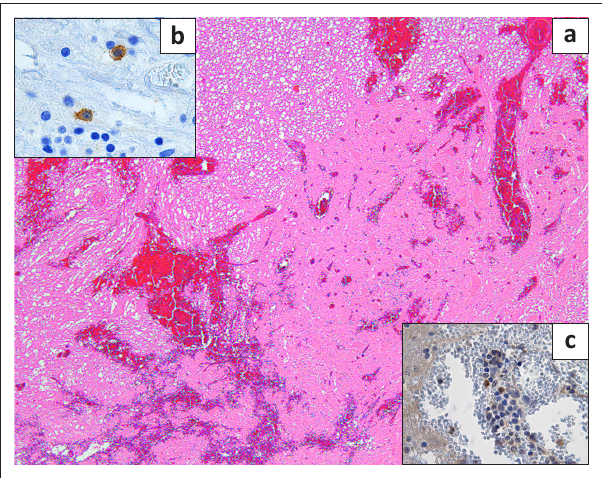
Source : Image was taken by June Williams HE x 40. FIGURE 3: (a) Lumbar spinal cord of lineage 2 West Nile virus Case 2 with severe multifocal to coalescing haemorrhage involving white and grey matter. (b) Case 2 cauda equina spinal cord ventral horn grey matter with two immunohistochemistry cluster of differentiation 20+ (brown) labelled plasma cells in parenchyma. Cluster of differentiation 20 immunoperoxidase using LSAB+ DAB as chromogen and haematoxylin counterstain x 1000. (c) Case 2 cauda equina grey matter perivascular immunohistochemistry Multiple myeloma oncogene1+ plasma cells (dark brown-black staining round nuclei). Multiple myeloma oncogene1 immunoperoxidase using polymer DAB as chromogen and haematoxylin counterstain x 1000.